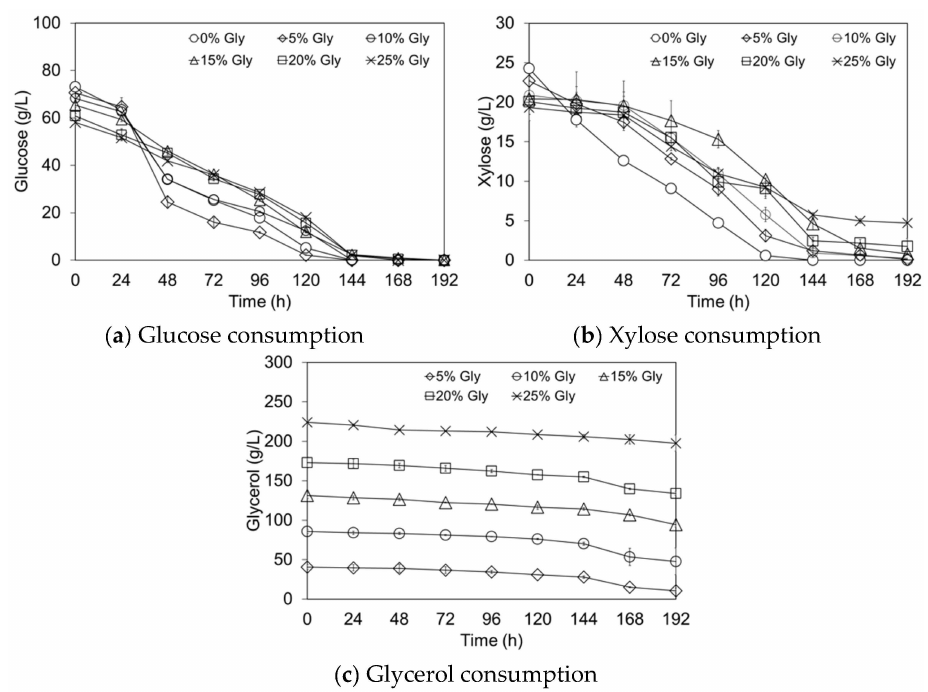
Figure 7. Profiles of carbon sources used in cultivation of R. glutinis TISTR 5159 in bagasse hydrolysate mixed with various amount of glycerol. Table 7. Carbon source use, lipid yield and cell yield when cultivating R. glutinis TISTR 5159 for 8 days in the bagasse hydrolysate mixed with glycerol at C/N molar ratio of 27. Initial C Source (g/L) Glycerol (% Used, Individual) Concentration (%) Glucose